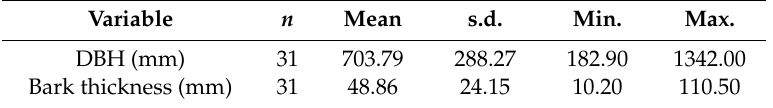
Table 14. Summary data for DBH and the breast-height bark thickness (BT) of redwood trees sampled for bark tapering (BT at various heights) at Arcata Community Forest, Humboldt County, California.